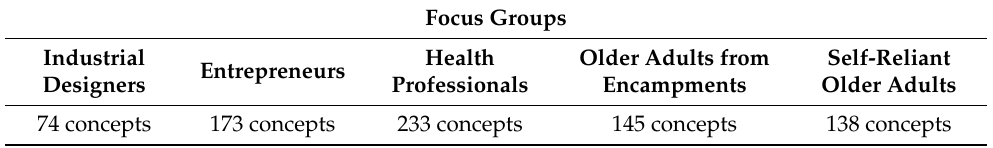
Table 1. Key concepts found in each focus group. Focus Groups